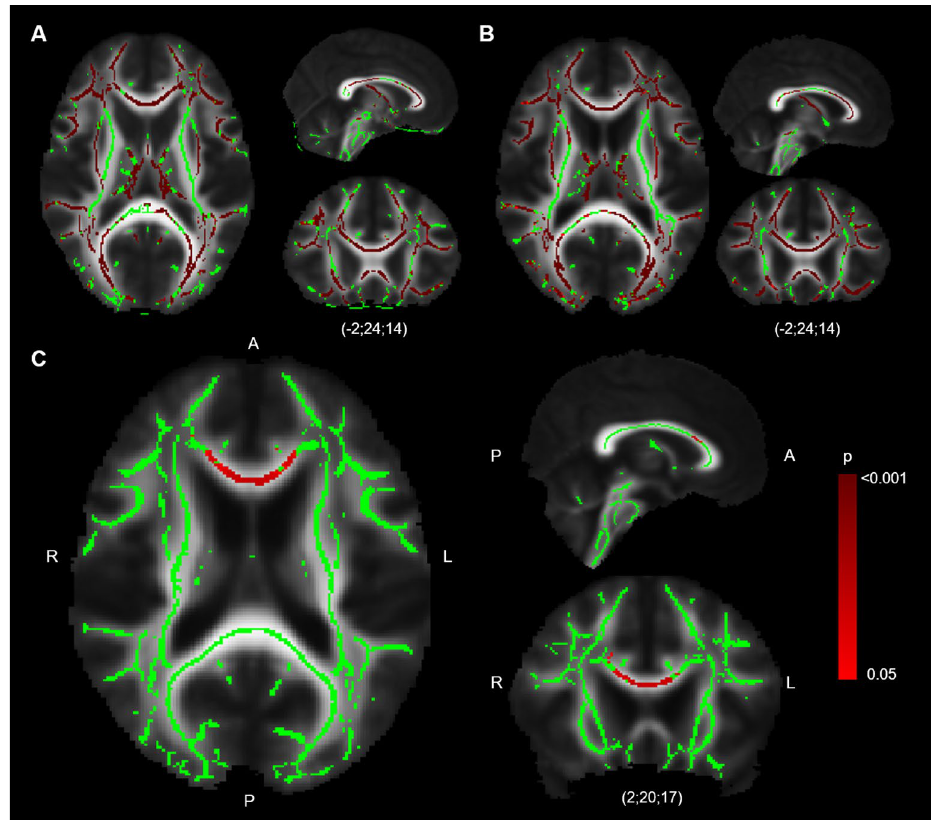
Figure 2. TBSS-Results, FA. TBSS-Results (red), projected on mean-FA-skeleton (green) and mean-FA image. TBSS-Results are thresholded: p < 0.05, FEW-corrected. ( A ) Y > O-HP, ( B ) Y > O-LP, ( C ) O-HP > O-LP, the images are in radiological orientation, coordinates are MNI-coordinates.